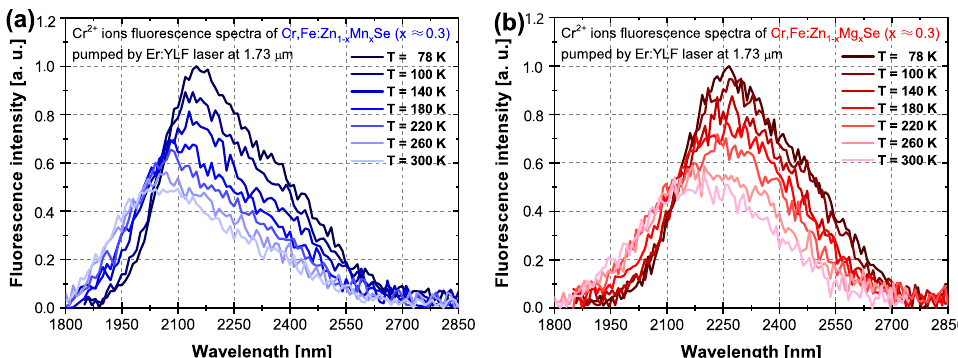
Figure 5. Temperature dependence of the Cr 2 + fluorescence spectra excited directly at the wavelength of 1.73 µ m. ( a ) Cr,Fe:Zn 1 − x Mn x Se x ≈ 0.3)—blue curves. ( b ) Cr,Fe:Zn 1 − x Mg x Se (x ≈ 0.3)—red